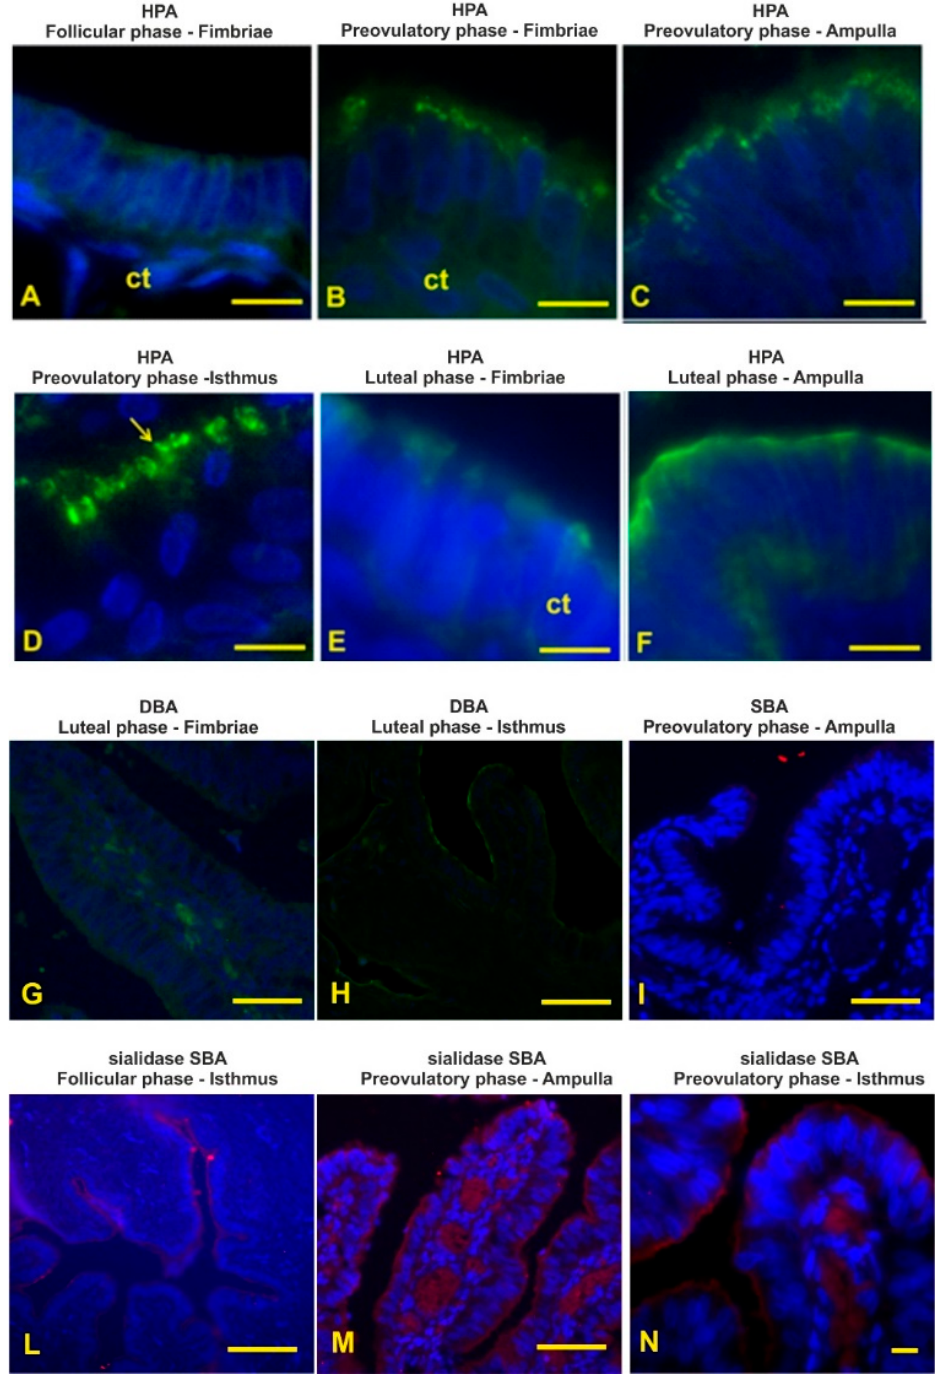
Figure 14. Localization of terminal GalNAc by means of HPA, DBA, SBA and sialic acid penultimate GalNAc terminating glycans by means of sSBA in the baboon Papio hamadryas oviductal epithelium during the menstrual cycle. ( A ) HPA-binding sites in the fimbriae during the follicular phase. ( B , C ) HPA reactivity with the fimbriae and the ampulla during the preovulatory phase. ( D ) HPA reactivity of the isthmus during the preovulatory phase. ( E , F ) HPA staining pattern of the fimbriae and ampulla during the luteal phase. ( G , H ) DBA reactivity of fimbriae and isthmus segments during the luteal phase. ( I ) SBA negative reaction with the oviductal epithelium (the picture shows fimbriae segment of a preovulatory animal). ( L ) Weak SBA staining of fimbriae from follicular baboon after KOH-sialidase treatment. ( M , N ) sSBA staining of the oviduct from preovulatory baboons. Key: ct, connective tissue; arrow, apical protrusion. Scale bar: ( A – F ) = 10 μ m; ( G – I , M ) = 50 μ m; ( N ) = 10 μ m.